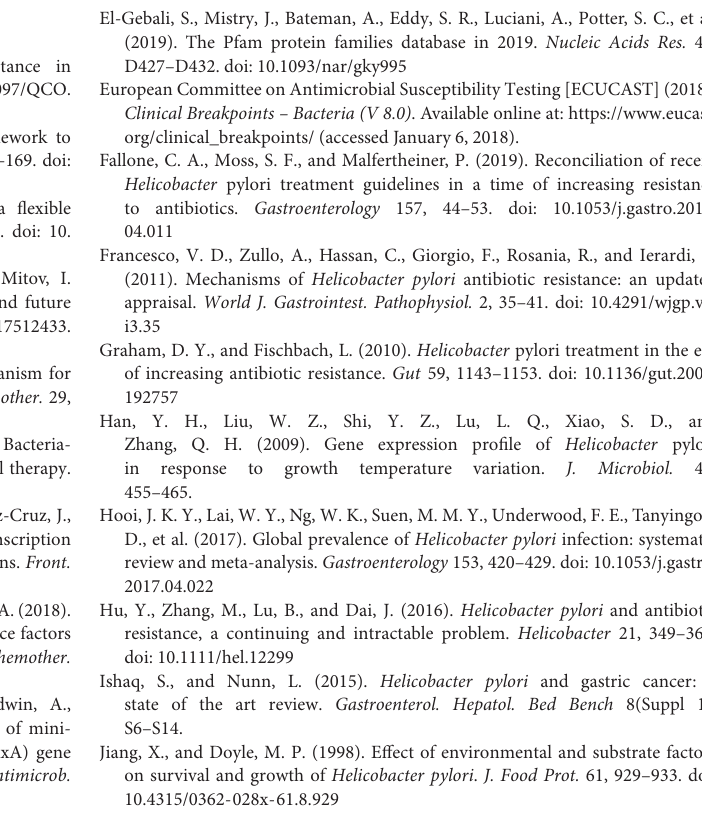
Supplementary Figure 2 | The DNA sequence blast of rdxA gene in H. pylori 26695 and H. pylori NCTC 11637. The H. pylori 26695 is sensitive to metronidazole but H. pylori NCTC 11637 is resistant. Compared with H. pylori 26695, the structural variation of rdxA gene in H. pylori NCTC 11637 included point mutations and the insertion of mini-IS605, which caused rdxA inactivation and thus metronidazole resistance. 11637- rdxA -37: the rdxA gene sequence of H. pylori NCTC 11637 cultured in 37 ◦ C. 11637- rdxA -41: the rdxA gene sequence of H. pylori NCTC 11637 cultured in 41 ◦ C. 26695- rdxA : the rdxA gene reference sequence of H. pylori 26695. The dashed rectangle showed the start site of rdxA gene and the solid rectangle showed the termination site of rdxA gene. The figure showed that the 11637- rdxA -37 and 11637- rdxA -41 were exactly the same. The high light region showed the insertion of mini-IS605, one of the endogenous transposable elements, in H. pylori NCTC 11637. Supplementary Figure 3 | The DNA sequence blast of frxA gene in H. pylori 26695 and H. pylori NCTC 11637. 11637- frxA -37: the frxA gene sequence of H. pylori NCTC 11637 cultured in 37 ◦ C. 11637- frxA -41: the frxA gene sequence of H. pylori NCTC 11637 cultured in 41 ◦ C. 26695- frxA : the frxA gene reference sequence of H. pylori 26695. The figure showed that the 11637- frxA -37 and 11637- frxA -41 were exactly the same. Supplementary Figure 4 | The DNA sequence blast of fdxB gene in H. pylori 26695 and H. pylori NCTC 11637. 11637- fdxB -37: the fdxB gene sequence of H. pylori NCTC 11637 cultured in 37 ◦ C. 11637- fdxB -41: the fdxB gene sequence of H. pylori NCTC 11637 cultured in 41 ◦ C. 26695- fdxB : the fdxB gene reference sequence of H. pylori 26695. The figure showed that the 11637- fdxB -37 and 11637- fdxB -41 were exactly the